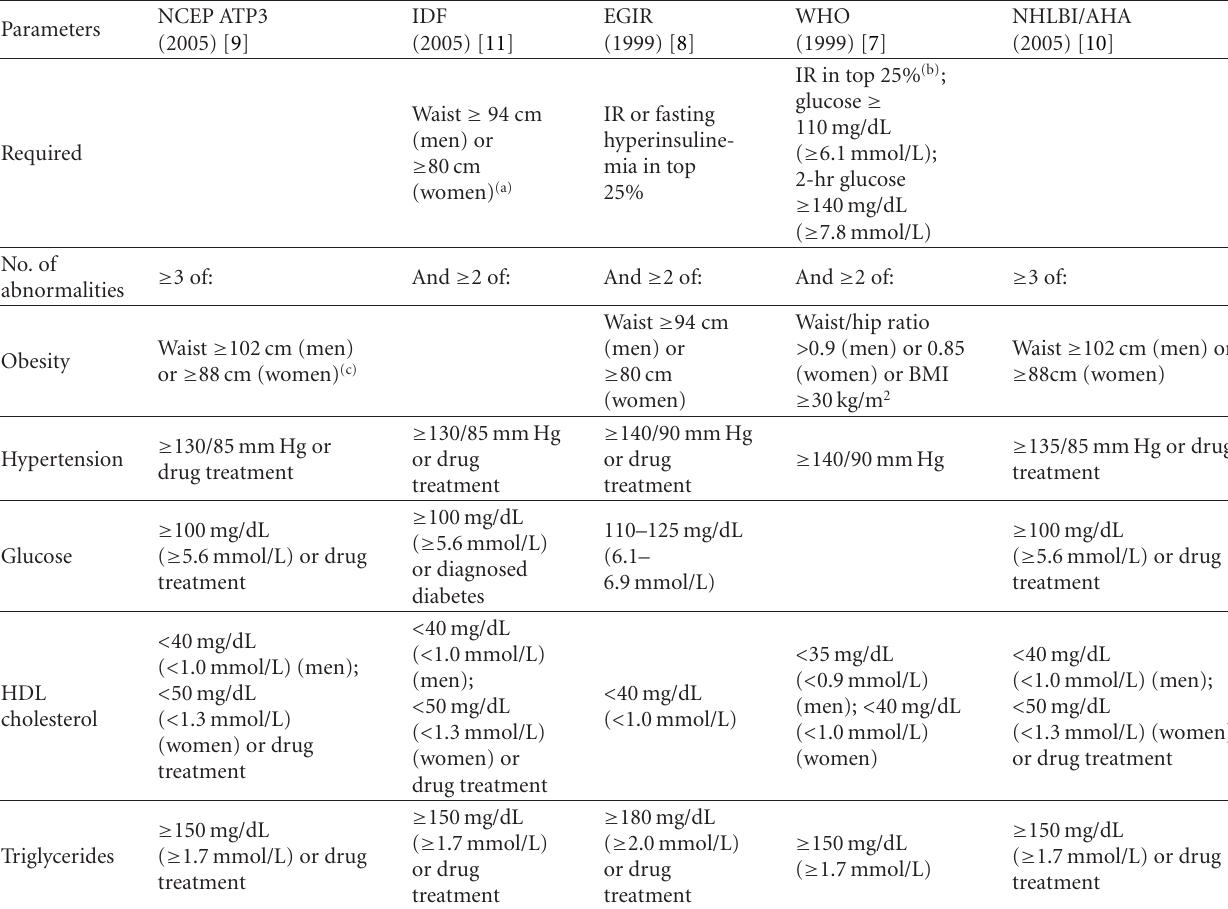
Table 1: Current definitions of the metabolic